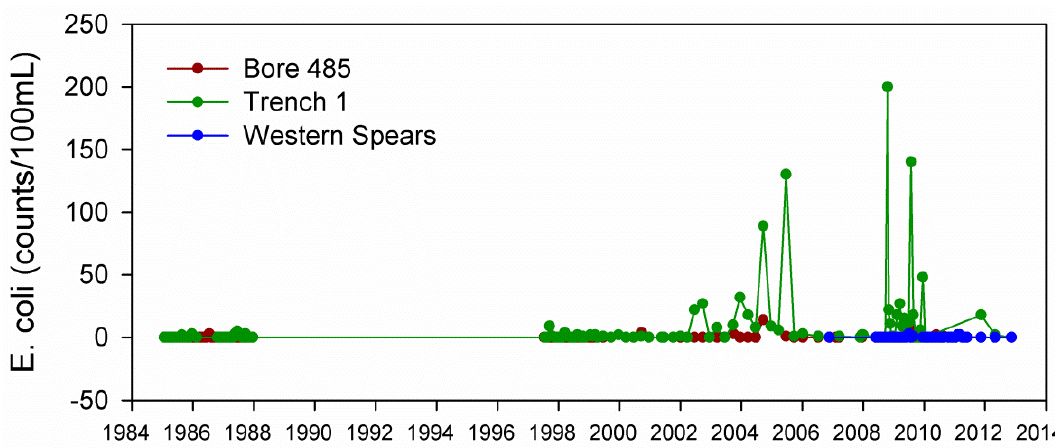
Figure 7. E. coli detection in Trench 1, Bore 485 and western spear